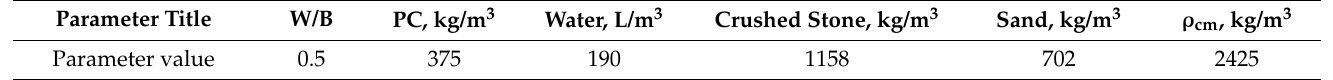
Table 4. Parameters of the composition of the concrete